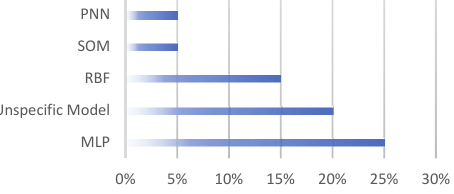
Fig. 10. Comparison of the Artificial Neural Network models